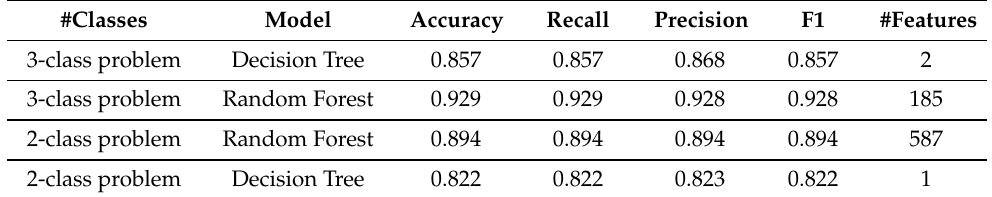
Table 6. Classification results for shadows and reflections using a single ML model for DT and